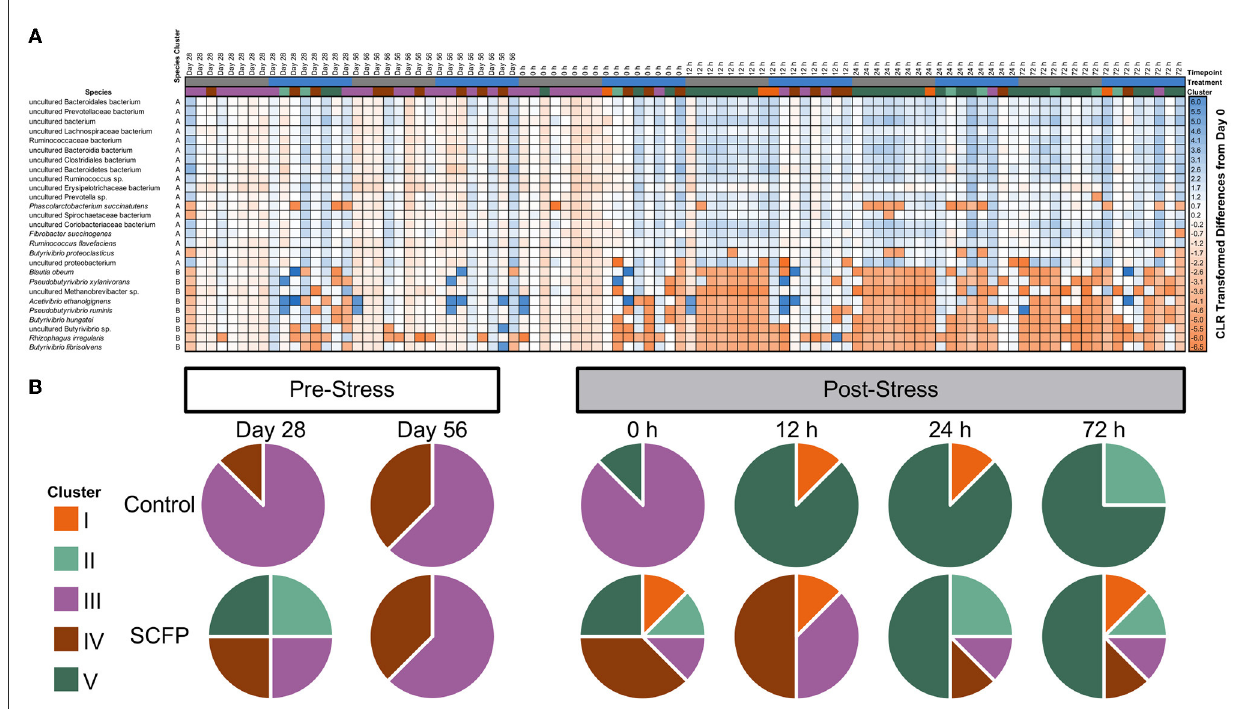
FIGURE4 Stress challenge results in different microbial profiles in Control and SCFP treated horses. (A) Heatmap of centered log-ratio relative abundance of bacterial species detected in fecal samples of horses. (B) Pie charts represent the presence of samples across different clusters for Control and SCFP groups across time. Species cluster A contains species that drastically increase in relative abundance upon stress challenge, whereas species cluster B is comprised of species which decrease after stress